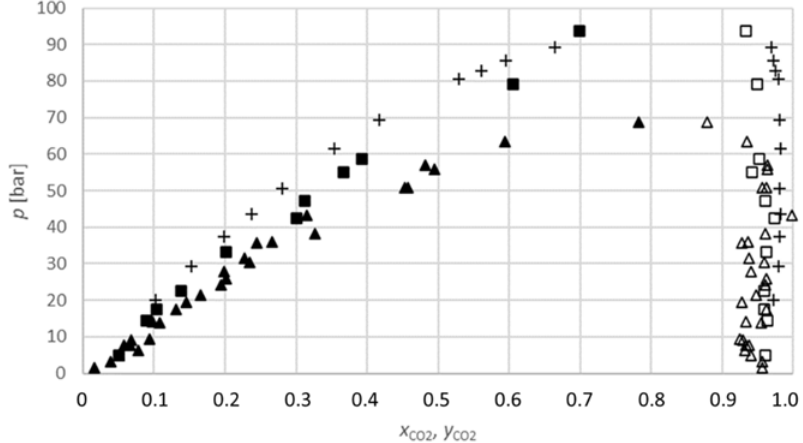
Figure 3. P-x,y diagram for the phase equilibria for the CO 2 -2-propanol binary system ( x CO2 , y CO2 : CO 2 mole fraction): ▲ , measured data at 313.15 K (lower phase); ■ , at 333.15 K (lower phase); ∆ , at 313.15 K (upper phase); ◻ , at 333.15 K (upper phase); +, Lim et al. (2007) at 333.15 K [22]. Lim et al. (2007) measured isothermal high-pressure VLE data for the binary mixtures